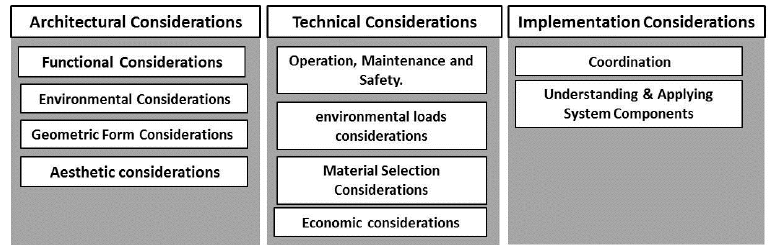
Figure 1. Kinetic Architecture Design considerations.